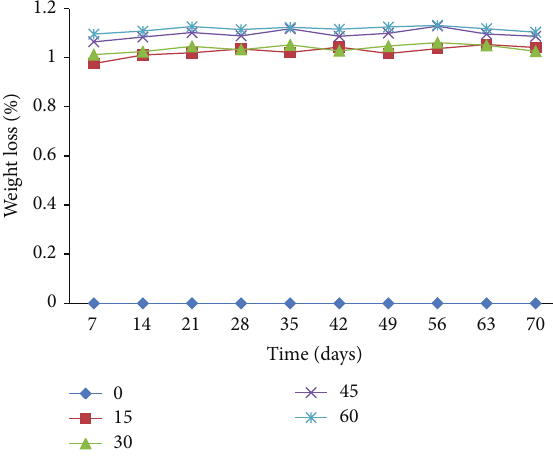
Figure 9: Weight loss after every 7 days in the presence of MA-g-PE.